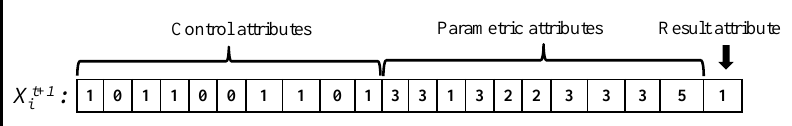
Figure 11. A sample of generating the new position of particle X i